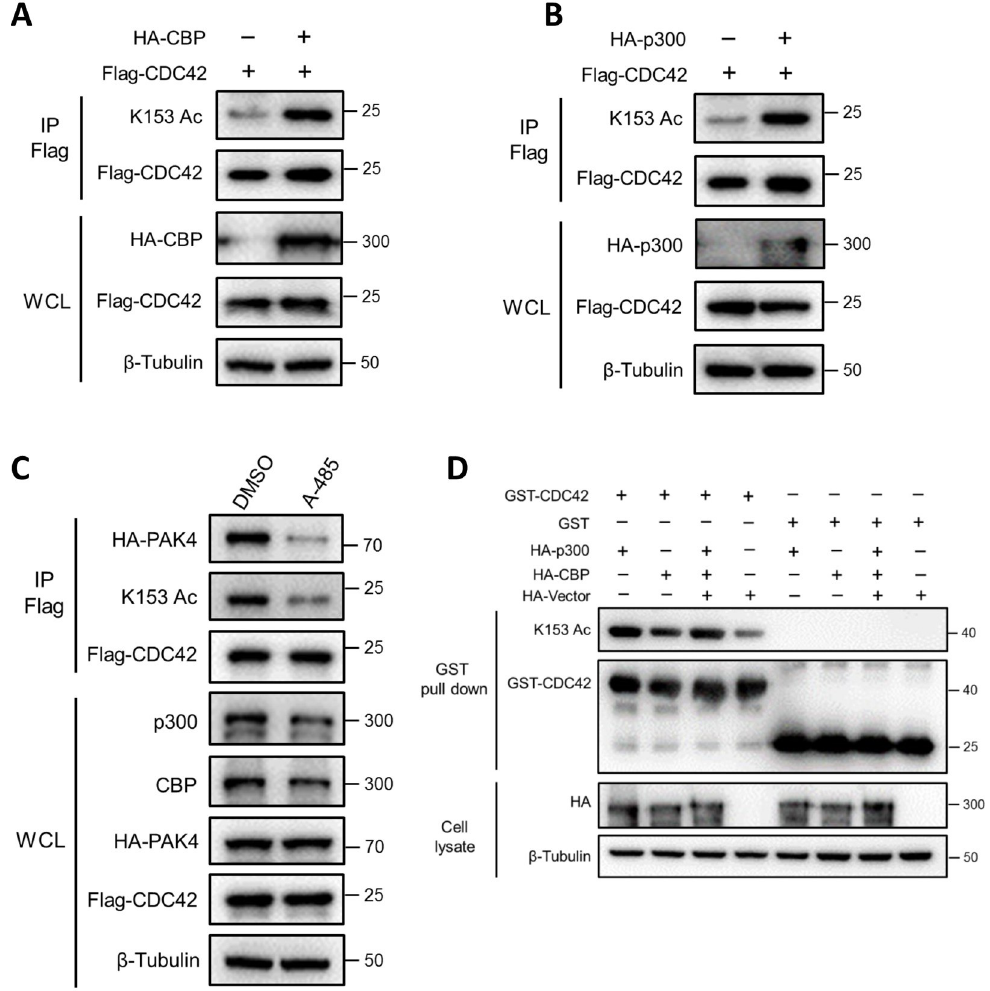
Fig 4. CDC42 K153 is acetylated by p300/CBP. CBP/p300 increases the acetylation level of K153. HA-CBP (A) or HA- p300 (B) was co-transfected with Flag-CDC42 into HEK293T cells, followed by IP with anti-Flag antibody and